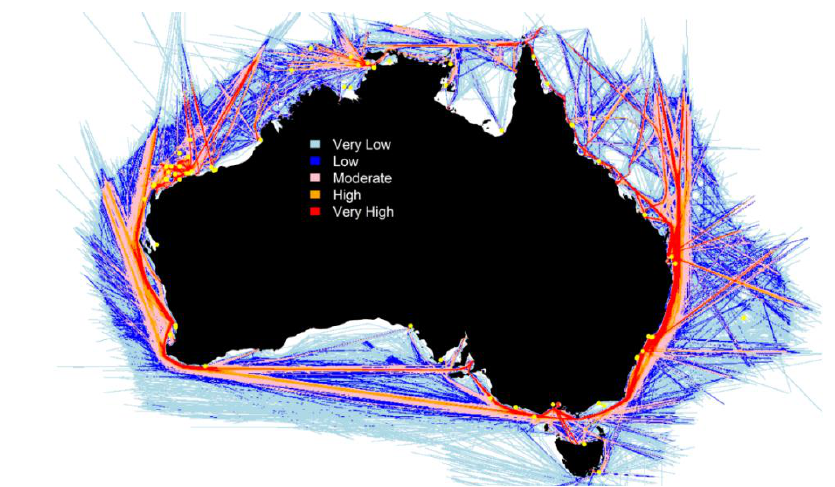
Figure 2. Observed collisions (any seriousness) during 1995 to June 2013 overlaid (as yellow circles) onto the risk assessment for collisions ( very serious and serious ) in the Australian EEZ.